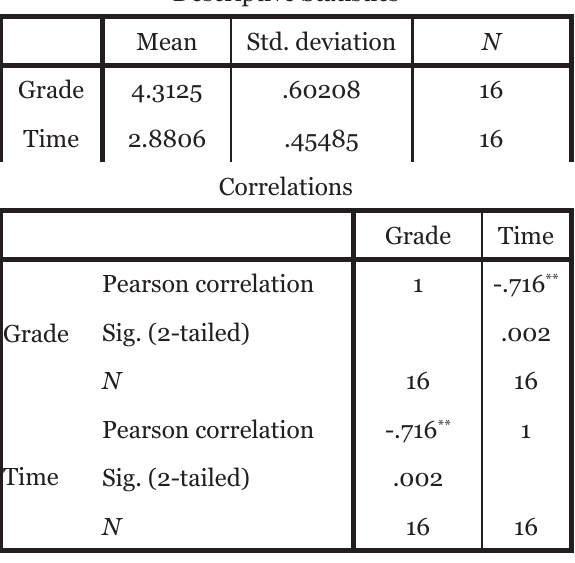
Correlation between Weekly Quiz Grade and Amount of Time Spent Completing the Quiz Descriptive Statistics